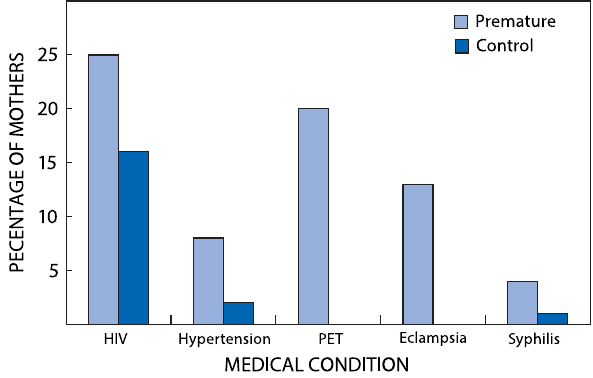
Figure 1: Percentage of mothers with pre-existing medical conditions in the premature and control groups